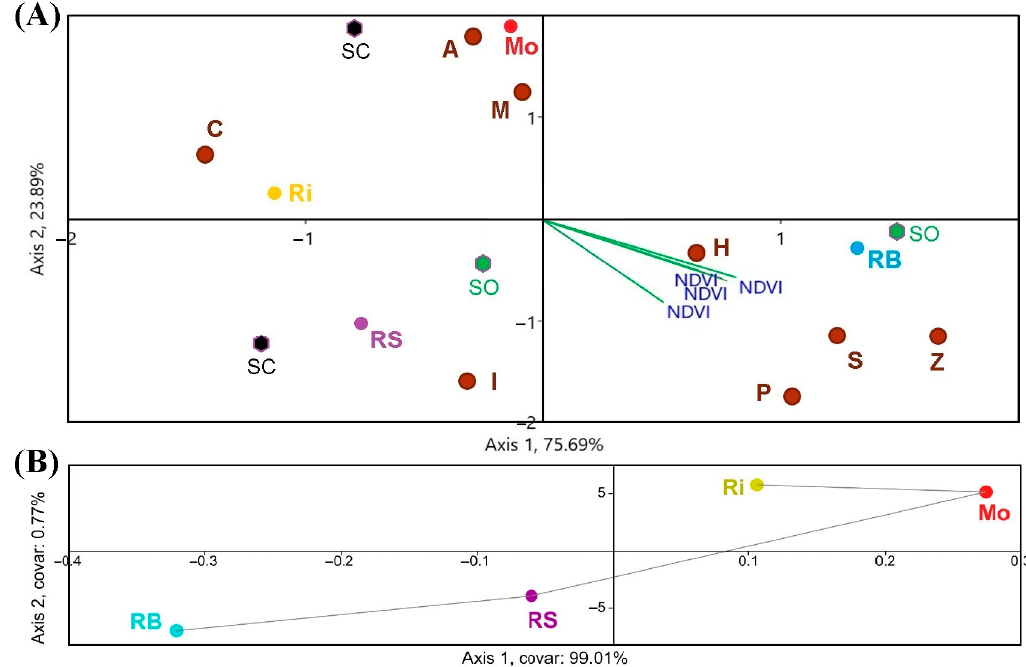
Figure 6. ( A ) CCA, ( B ) TB-PLS of the NDVI–species richness correlation. Single letters are the species (A, Aureobasidium spp.; C, Cryptococcus spp.; H, Hanseniaspora uvarum ; It, Issatchenkia terricola ; M, Metschnikowia spp.; P, Pichia spp.; S, Starmerella bacillaris ; Z, Zygosaccharomyces spp.) in the four DO (Monterrei, Mo; R í as Baixas, RB; Ribeira Sacra, RS; Ribeiro, Ri), according to organic (SO) and conventional production system (SC).